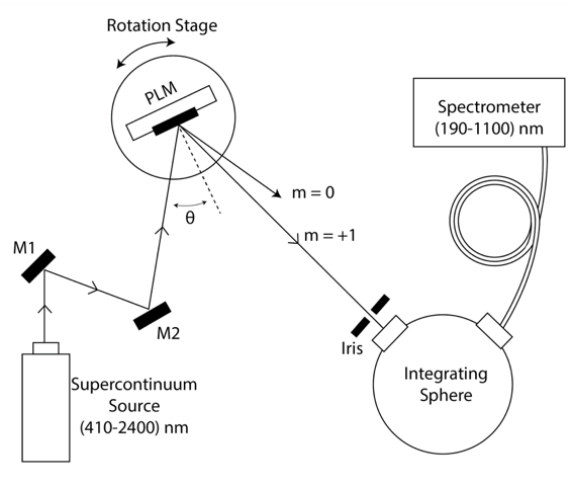
Figure 3. Experimental setup for measuring the diffraction efficiency across the visible spectrum. A supercontinuum laser source (SuperK Extreme from NKT Photonics) was used for simultaneous characterization of diffraction efficiency across a broad range of